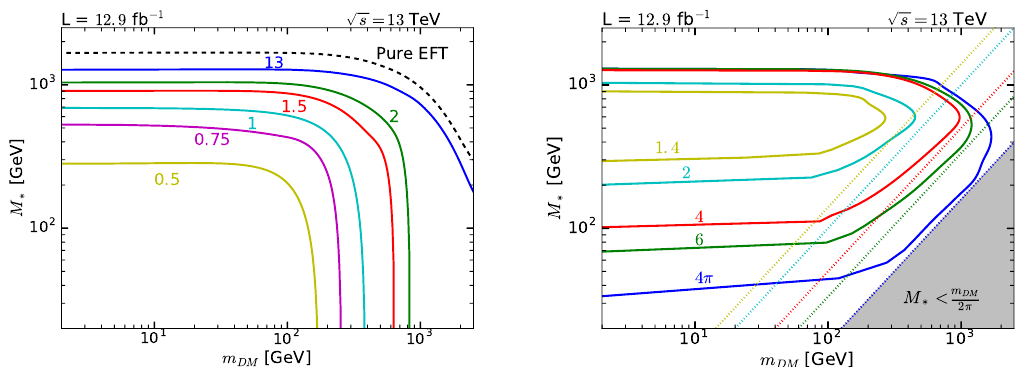
Figure 2 . Limits in the m - M (cid:3) plane at (cid:12)xed M cut (left panel) and g (cid:3) (right panel), obtained DM from the reinterpretation of ref. [34]. The dashed lines on the right plot represent the boundaries of the theoretically forbidden region 2 m > M cut = g (cid:3) M (cid:3) at (cid:12)xed g (cid:3) . In this region, DM production DM never occurs within the range of validity of the EFT and no limit can be set. The meaning of the \Pure EFT" line on the left plot is explained in the